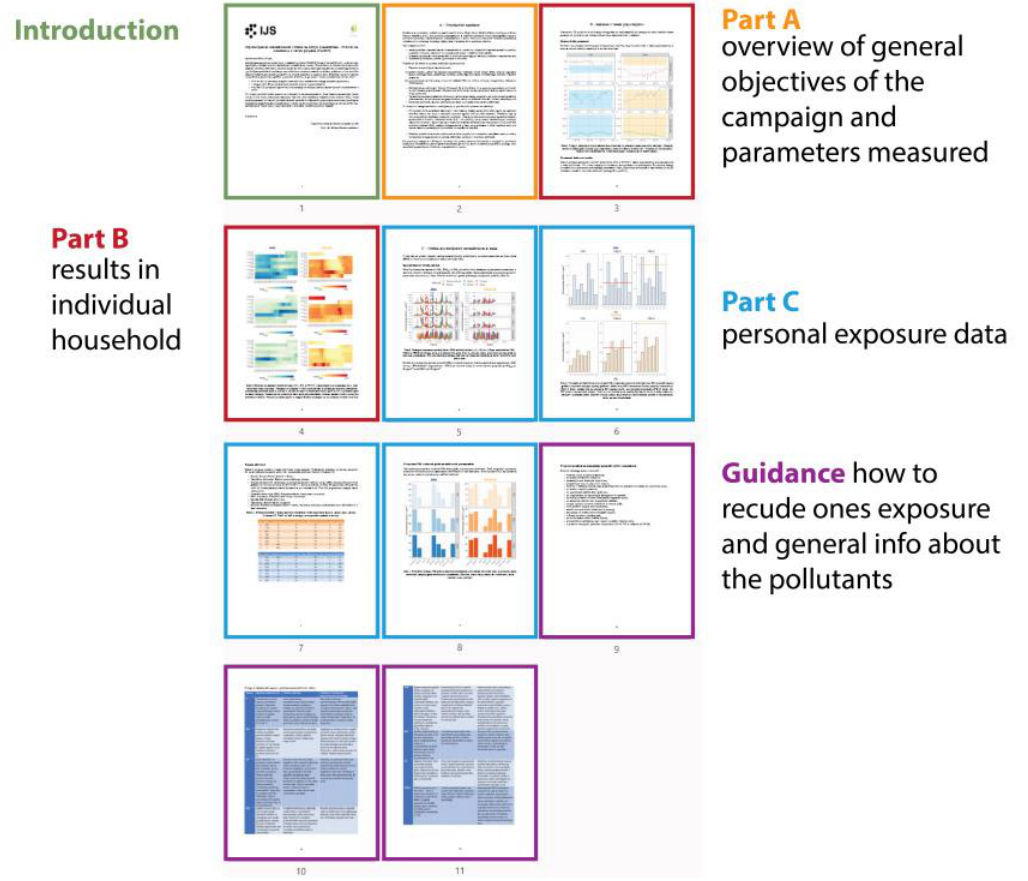
Figure 3. Structure of the final results report.